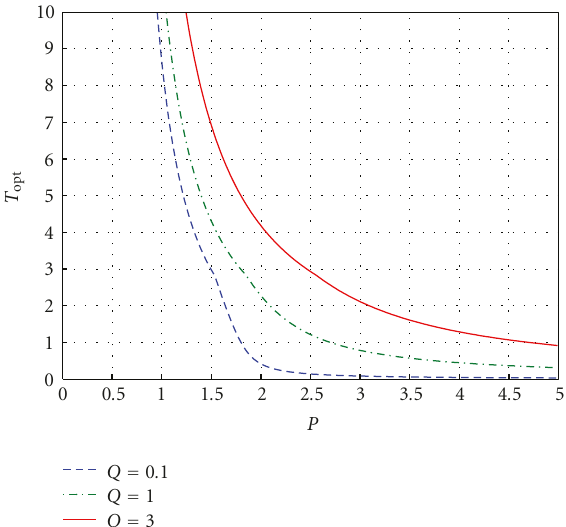
Figure 15: The optimal T opt under policy π 2 for di ff erent Q.